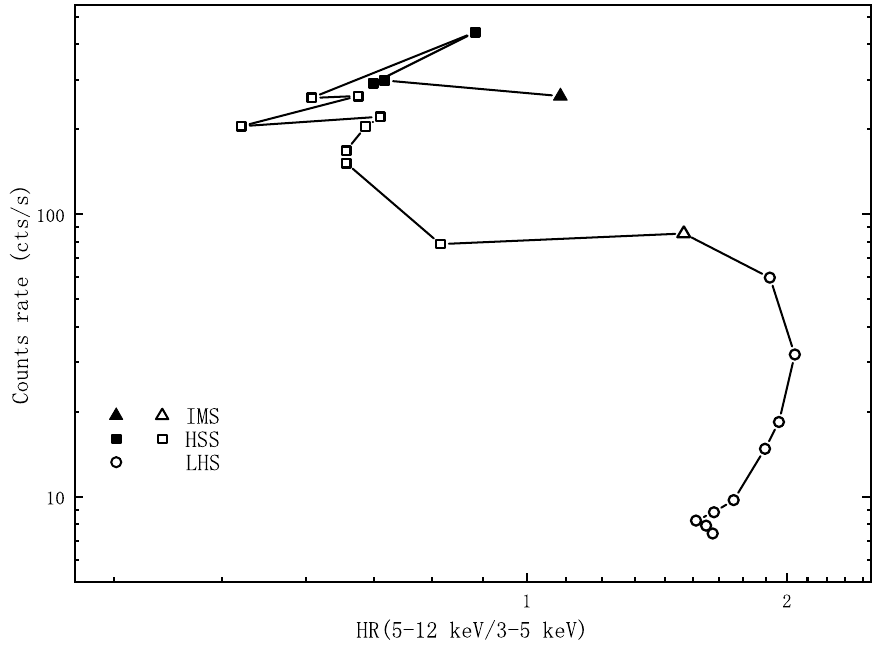
Figure 2. The HID of H 1743-322 during the “faint” 2005 outburst. The symbol types are the same as Figure 1.